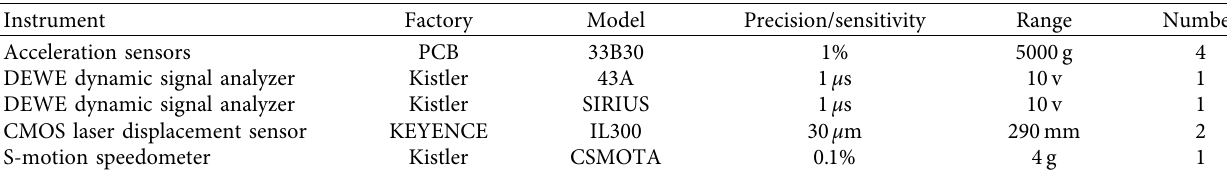
pitch/roll angle and of vertical acceleration for the left front/ rear wheel, the left front/rear body, and the centroid of the